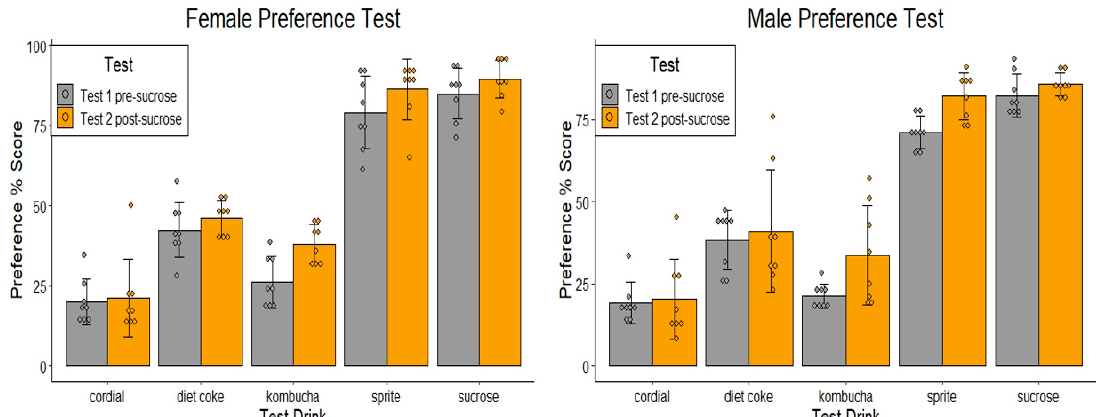
Figure 2. Preference tests performed in female and male naïve animals (Test 1 pre-sucrose) and following 4 weeks of sucrose exposure (Test 2 post-sucrose) during Phase 1. Mean % ( ± SEM) preference of the assigned test drink over water during 10 min two-bottle preference tests. The control group received 10% w / v sucrose ( n = 8/group).